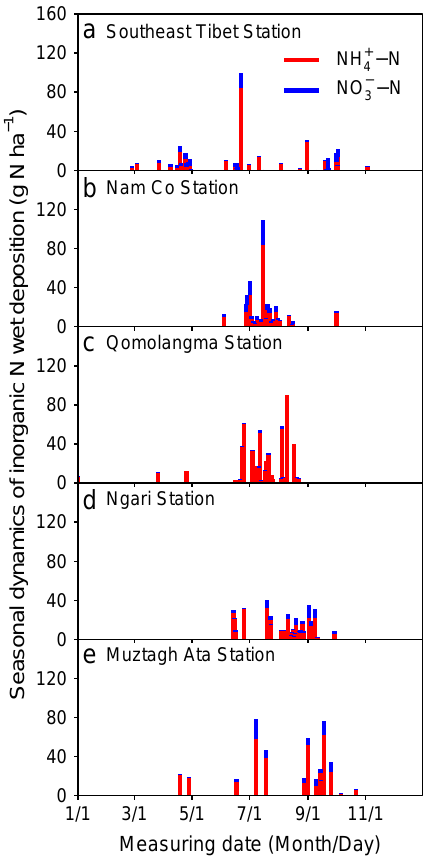
Figure 4. Seasonal dynamics of inorganic N wet deposition at five remote sites in the TP. The sampling time windows of those sites are the same as in Fig.